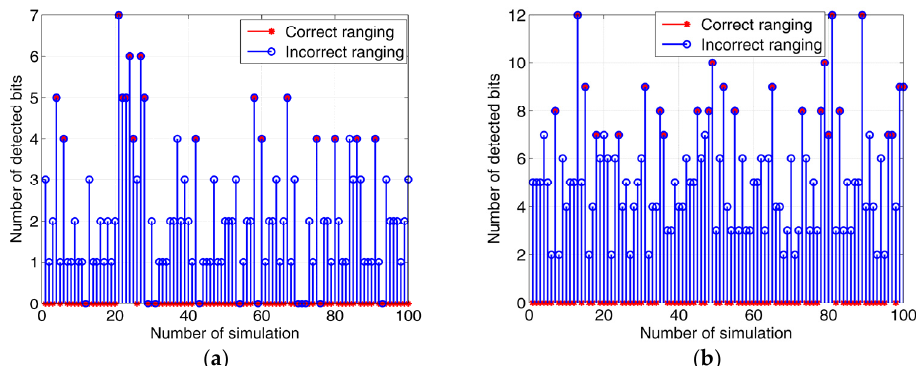
Figure 3. The detected number of codes at peak position of correlation operation. ( a ) Sequence length 100 μ s; ( b ) Sequence length 500 μ s.